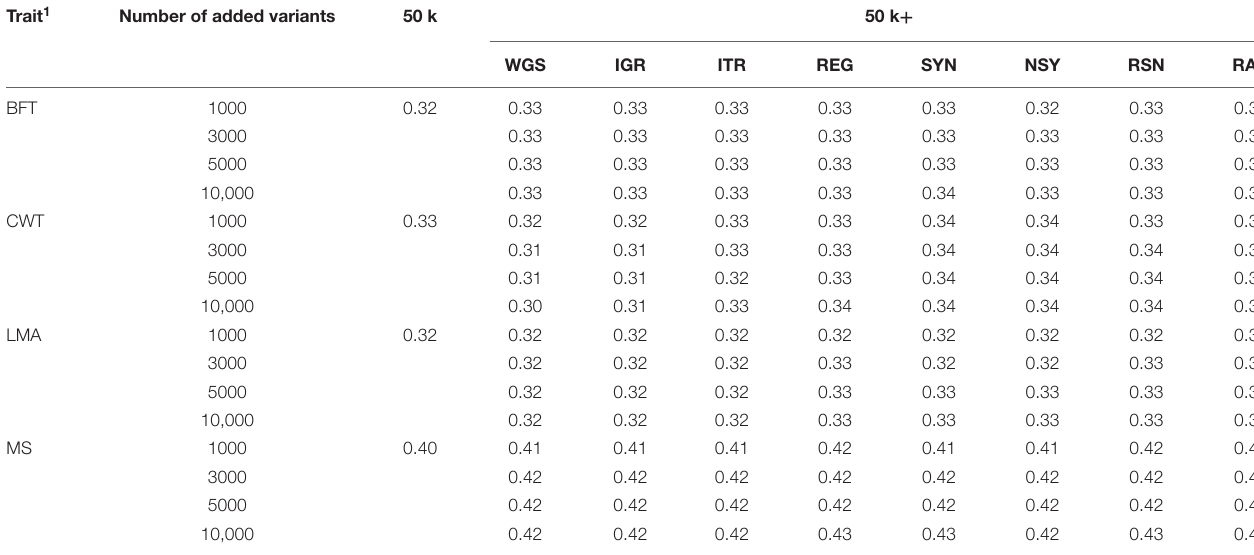
TABLE 3 | Estimates of heritability for carcass traits of Hanwoo cattle based on different SNP sets.* Trait 1 Number of added variants 50